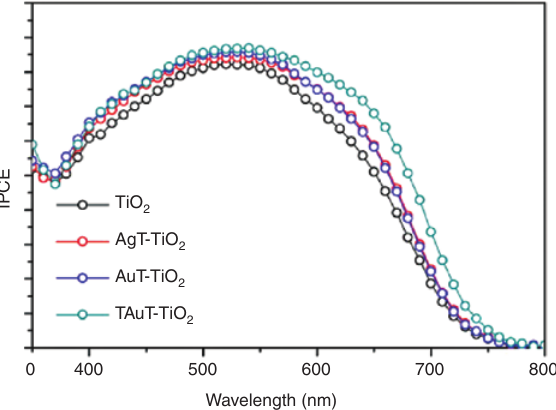
Figure 14: IPCE spectra of DSSCs with AgT, AuT, and TAuT NPs incorpo- rated photoanodes of optimized thickness for maximum PCE. Reprinted with permission from [83]. Copyright 2013 American Chemical